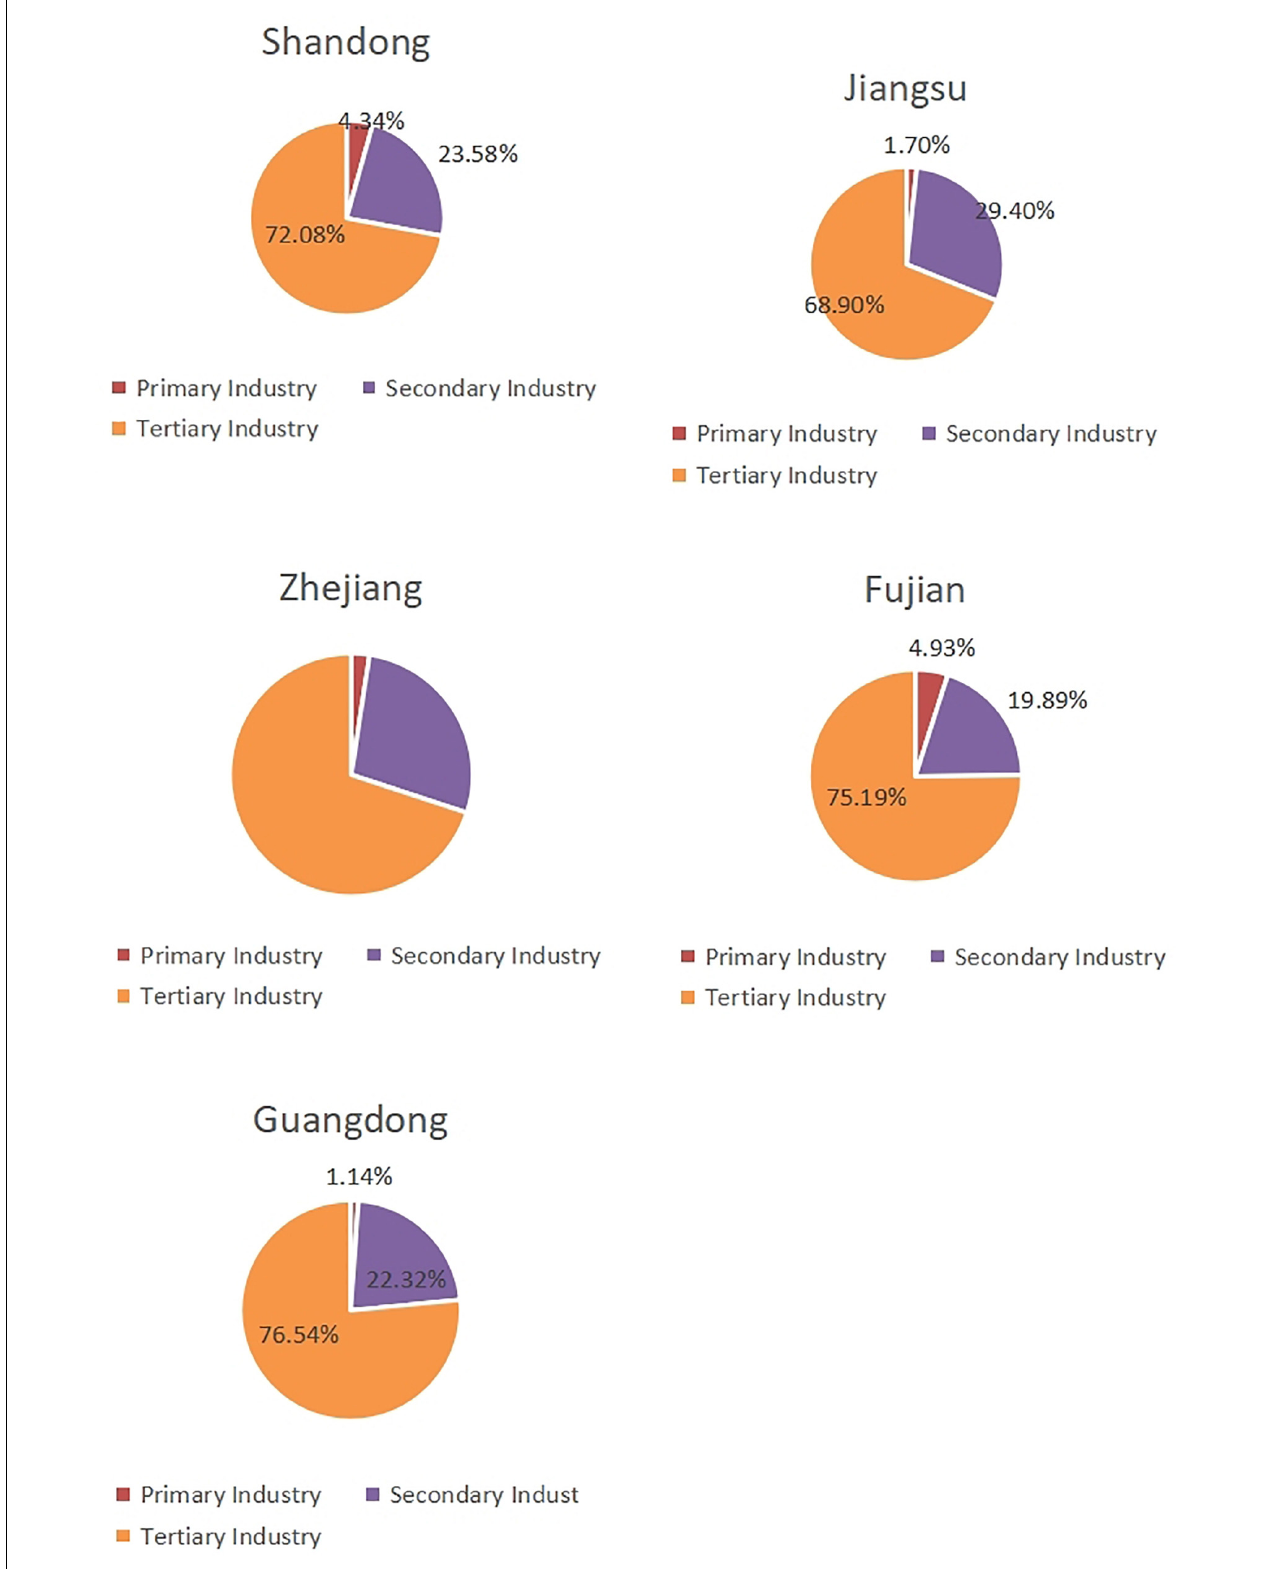
FIGURE 3 | Proportion of legal entity by industry in the five